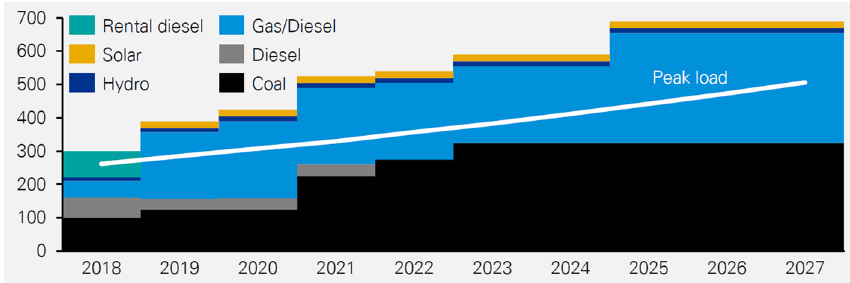
Fig. 5 The total planned installed production capacity and expected peak load demand (MW) in Lombok, for the years 2018–2027 (Embassy of Denmark (Jakarta), Danish Energy Agency, KPMG 2019)